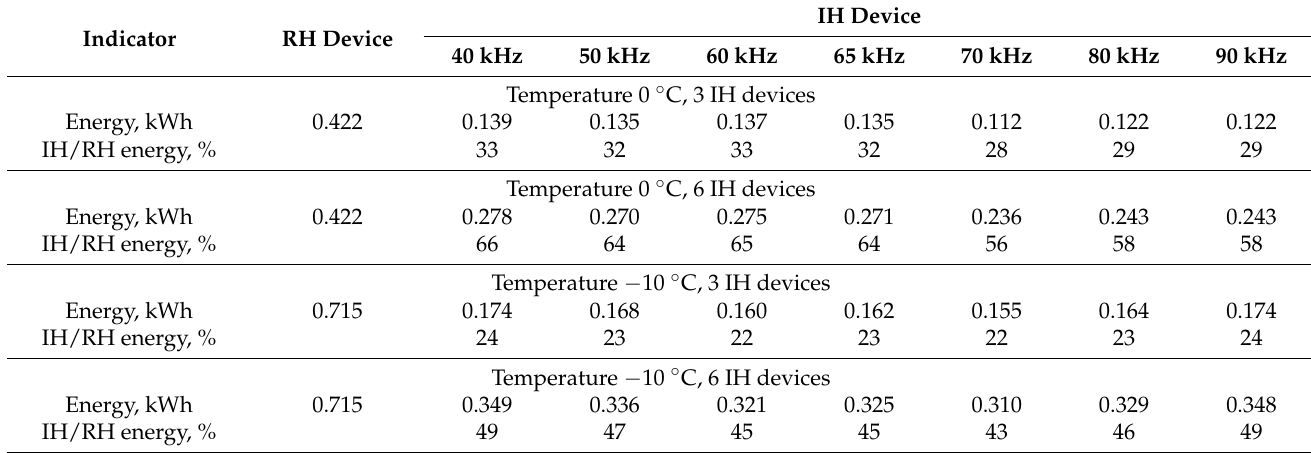
Table 3. Equivalent energy consumption of RH and IH devices when melting sample ice